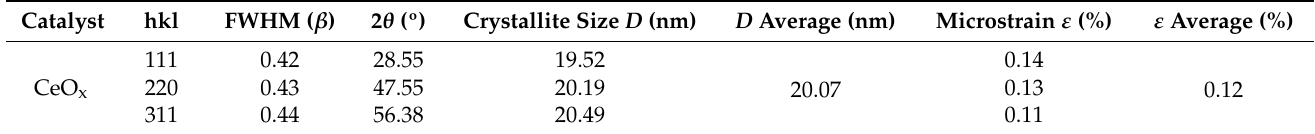
Table 1. Grain size and microstrain of the